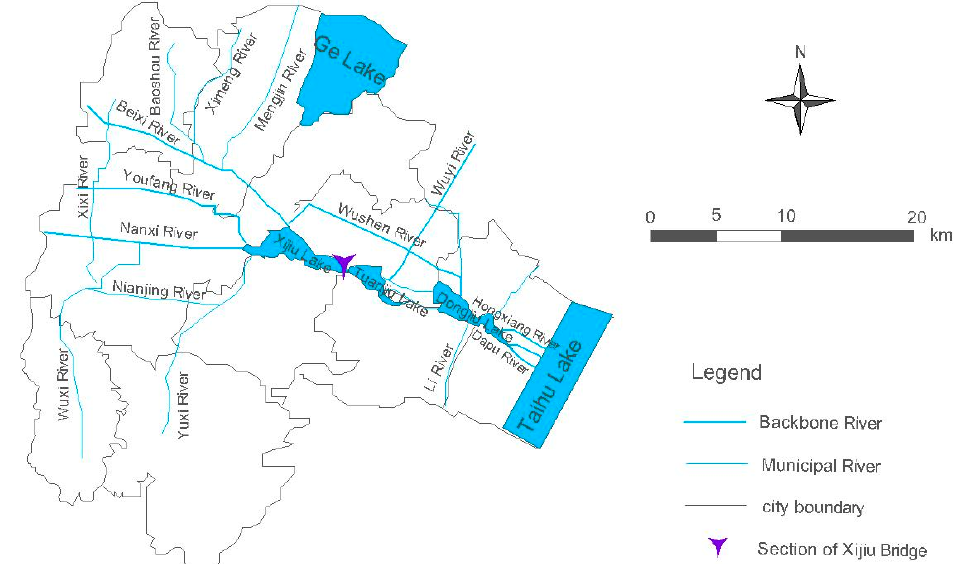
Figure 1. Water System of Study Area.